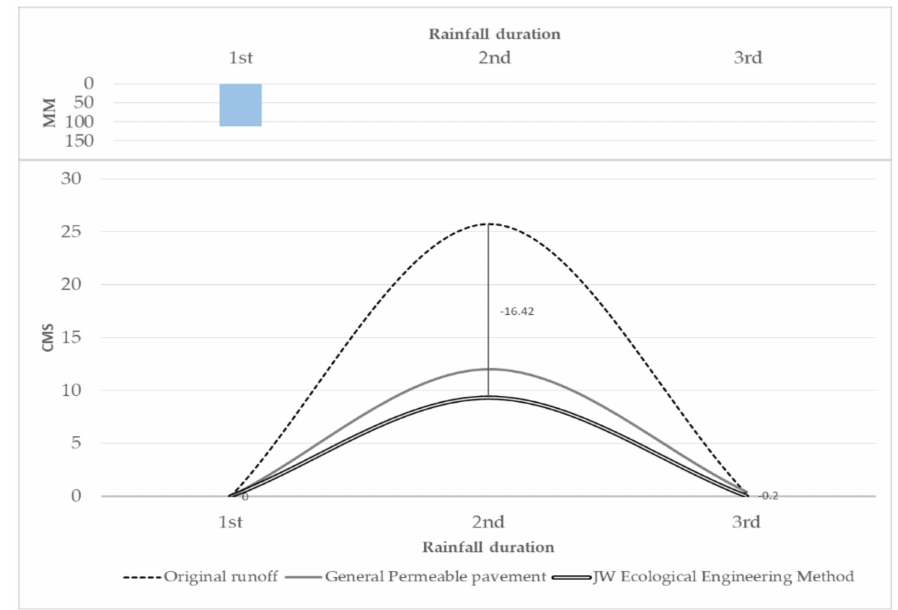
Figure 5. Simulation result for 1 h/112